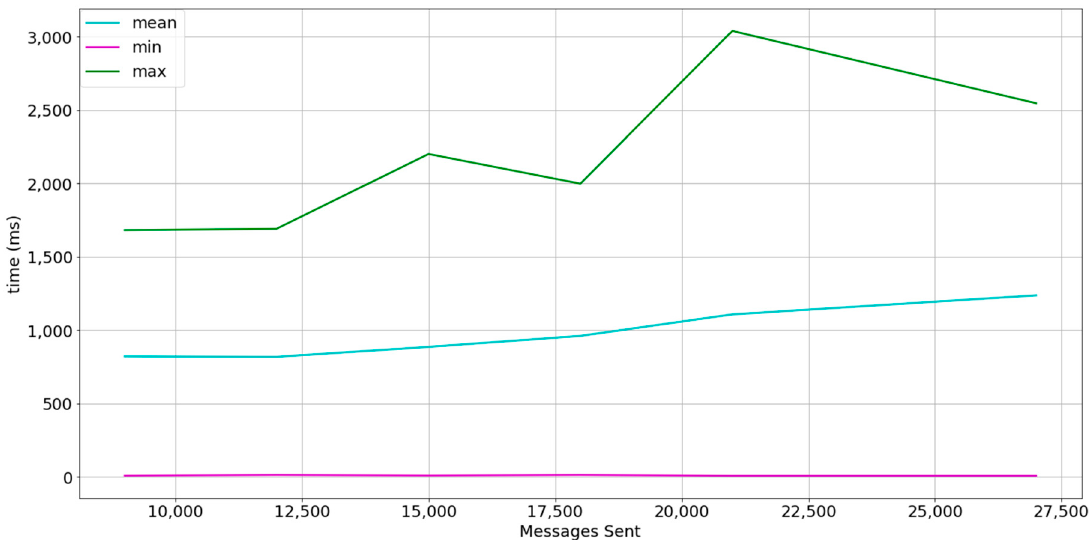
Figure 9. Results in experiment description setting 1 at a 5-s interval between bursts. The line in cyan represents the mean timedelta, the line in magenta represents the minimum timedelta, and the green line represents the maximum timedelta.